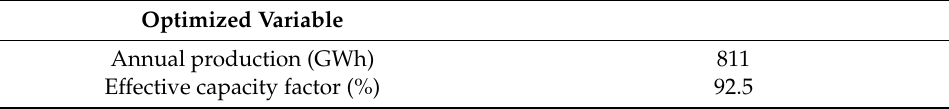
Table 6. Economic and financial results for the optimal CSP plant.